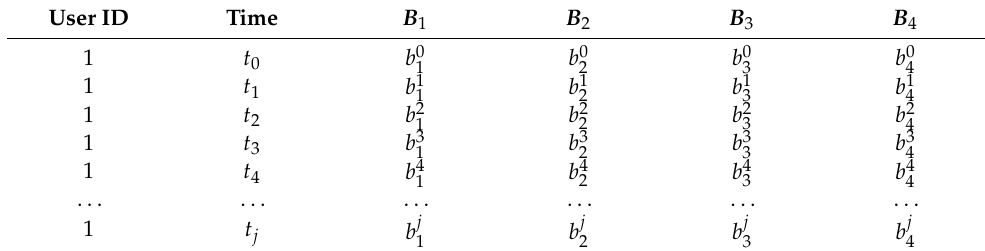
Table 1. Raw indoor movement trajectory of a sample